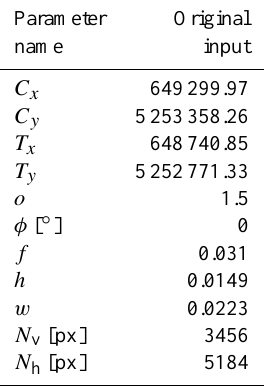
Table 1. Initial input data of PRACTISE for the test site Schneefern- erkopf. The coordinates are referenced to the European Terrestrial Reference System 1989 (ETRS89) and UTM Zone 32T. The values are in m except noted